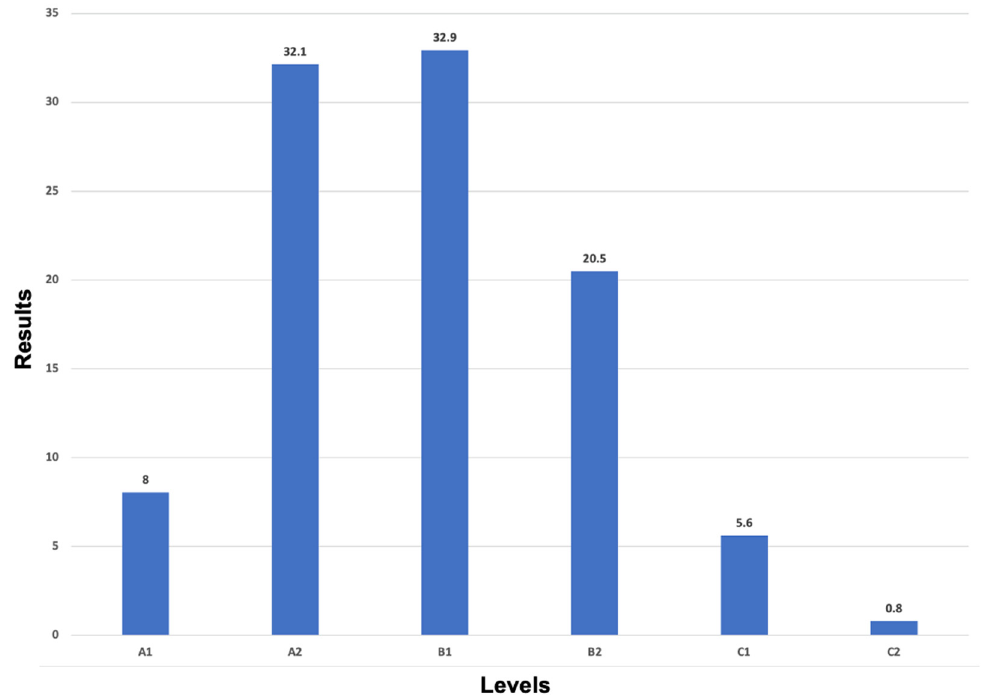
Figure 1. Results by level.